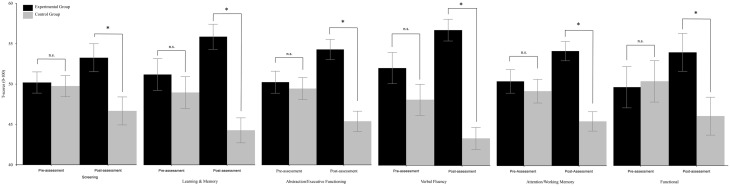
Between-groups comparisons (domains) along time (pre- vs. post-assessment). Error bars represent standard errors. Asterisks indicate significant comparisons, n.s. indicate non-significant comparisons.